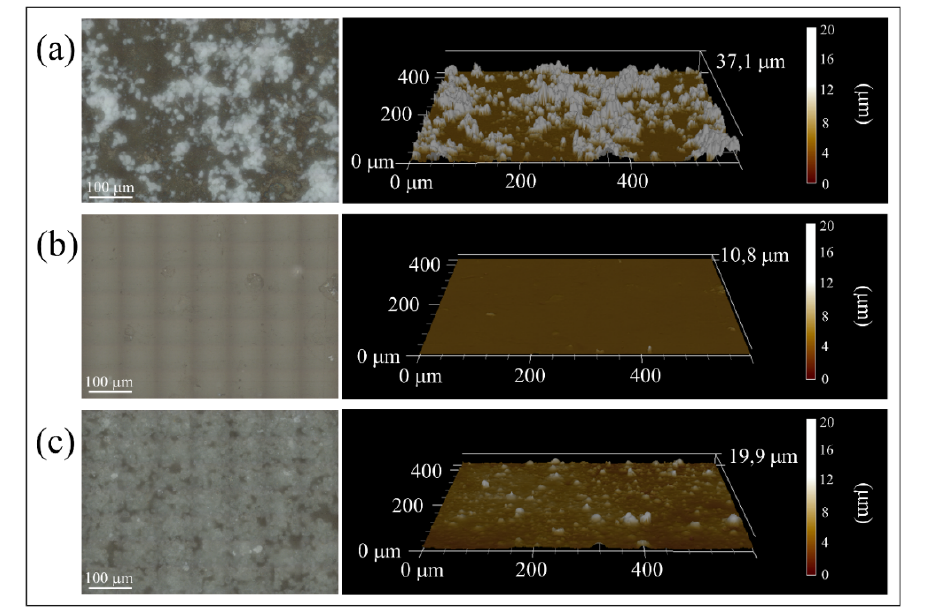
Figure 8. Laser microscopy images (left side) and relative topographic data (right side) of ( a ) bulk Si 3 N 4 (positive control), ( b ) PE substrate, and ( c ) Si 3 N 4 -coated PE substrate after SaOS-2 cell treatment.